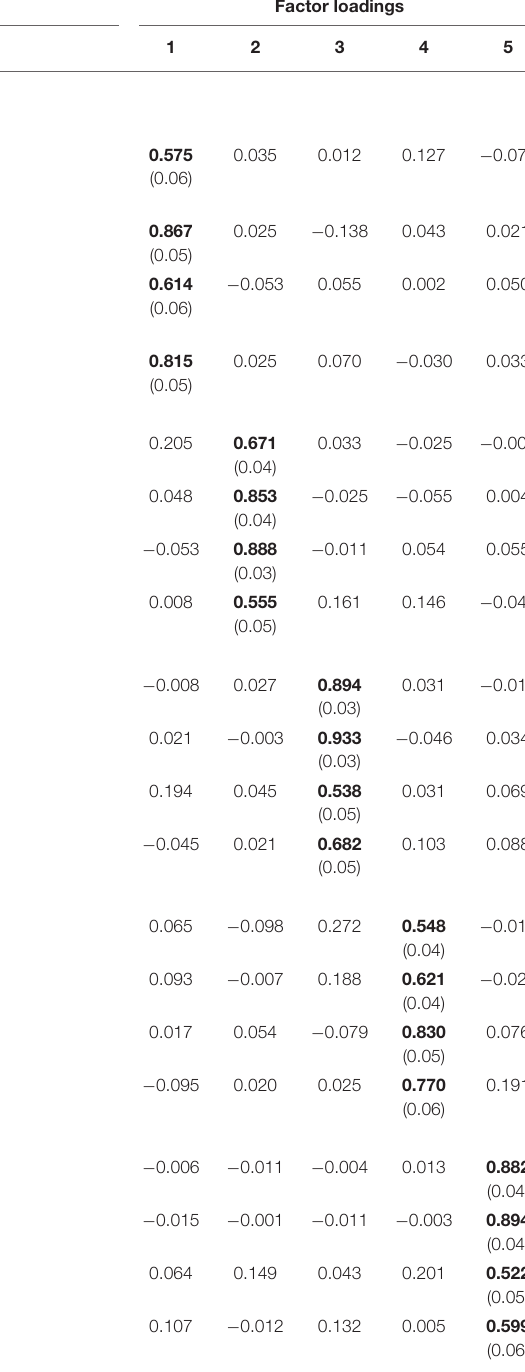
TABLE 2 | Factor loadings of exploratory factor analysis ( N = 339 ). Items Factor